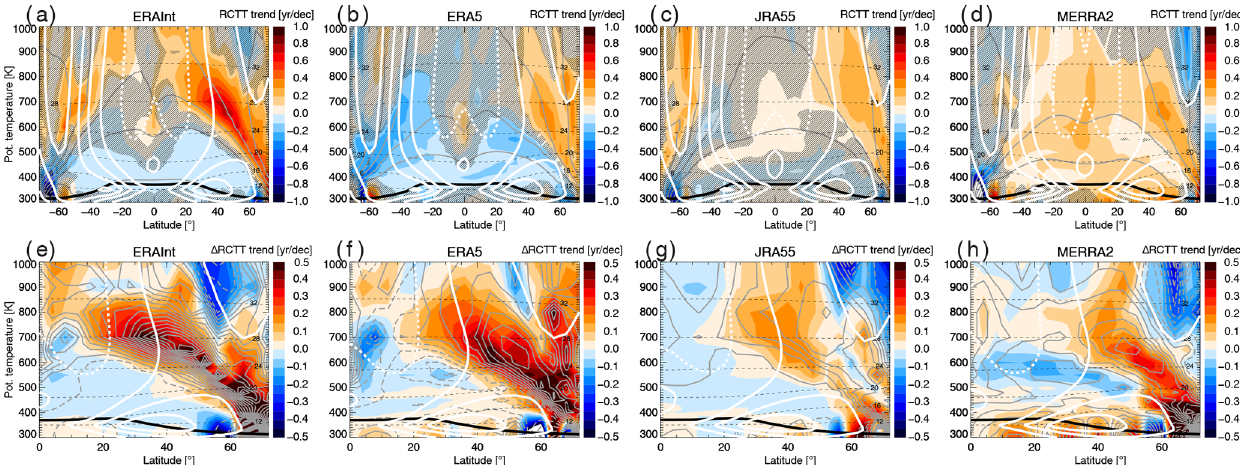
Figure 6. (a–d) Residual-circulation transit time RCTT trends for the period 2005–2017 for ERA5, ERA-Interim, JRA55 and MERRA2. (e–h) Hemispheric difference in RCTT trends (NH minus SH) for the different reanalyses. Grey lines show climatological RCTT (a–d) and the NH trend values ( e–h ; solid for positive, dashed for negative values), white lines show zonal wind contours (solid for positive, dashed for negative values), thin dashed black lines show log-pressure altitude levels, and the thick black line shows the WMO tropopause.